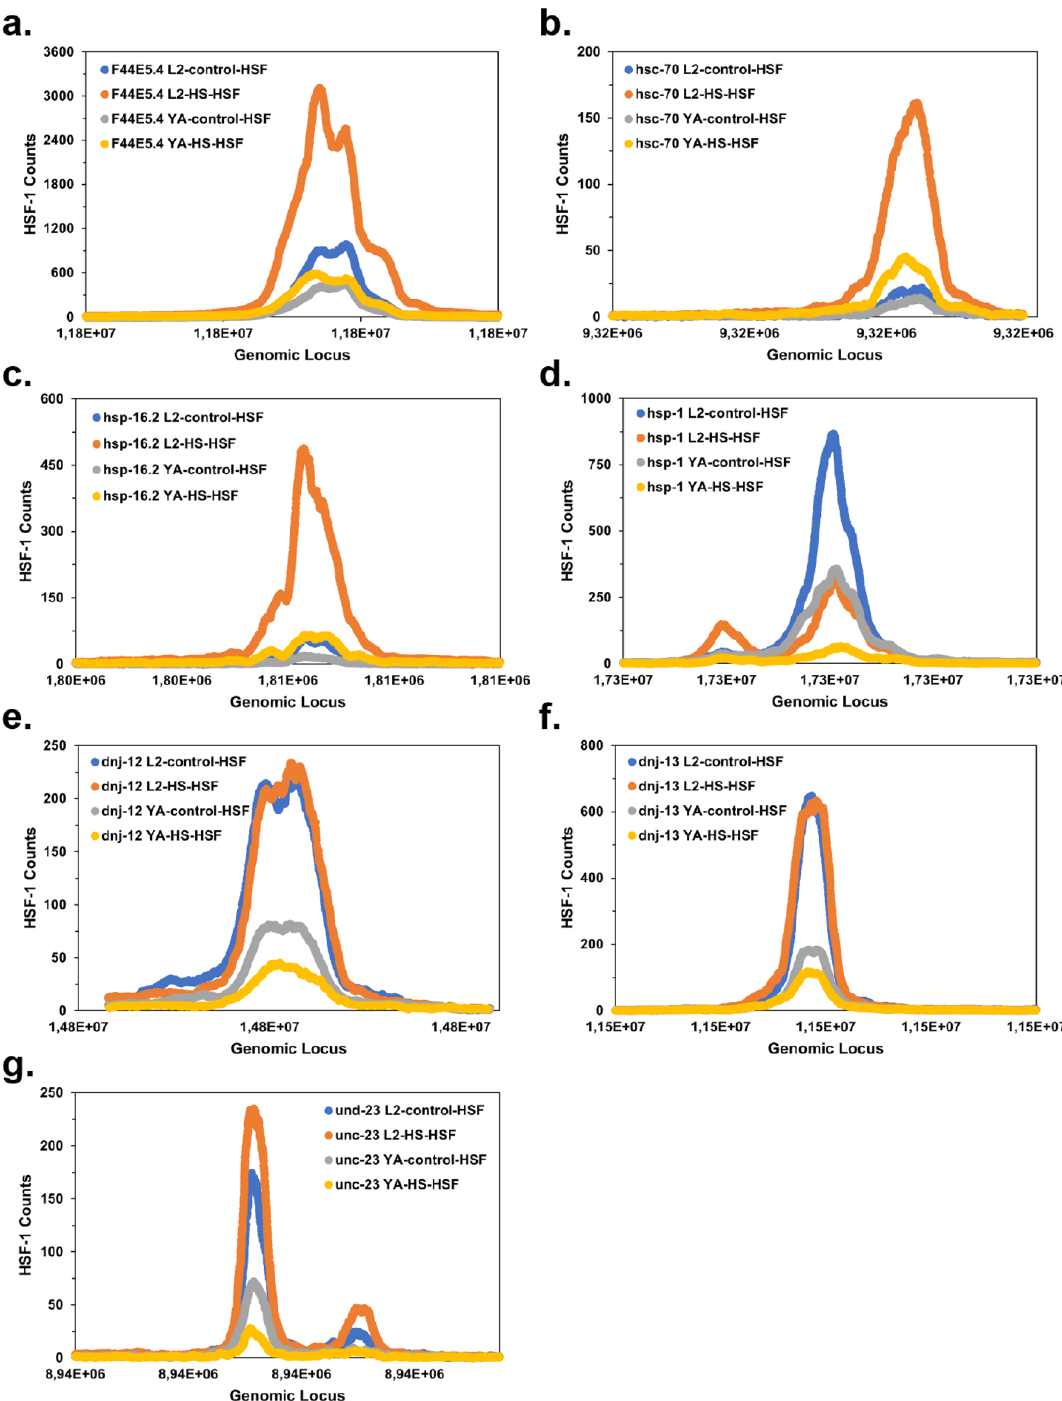
Figure 7. Promoter regions of C. elegans were investigated to identify the occupancy as determined by HSF-1 ChIPseq data of Li et al . 17 . Four experiments were compared based on the available data: Young adult with and without heat-shock and L2 larvae with and without heat-shock for all the promoter regions investigated